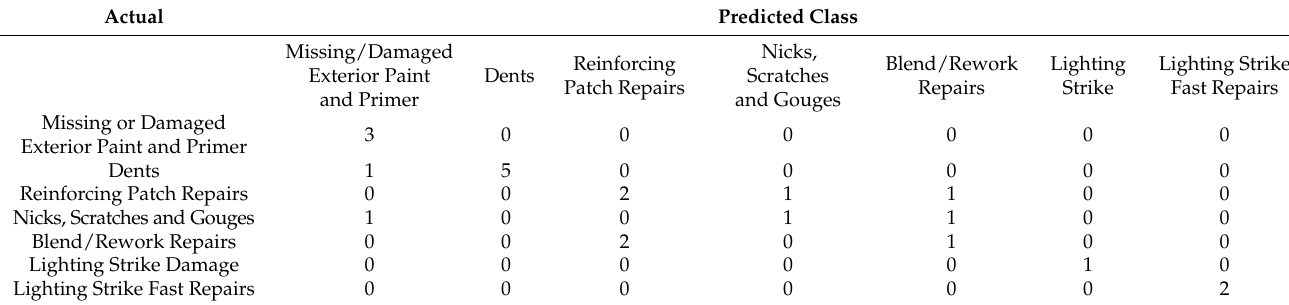
Table 18. Confusion matrix of the